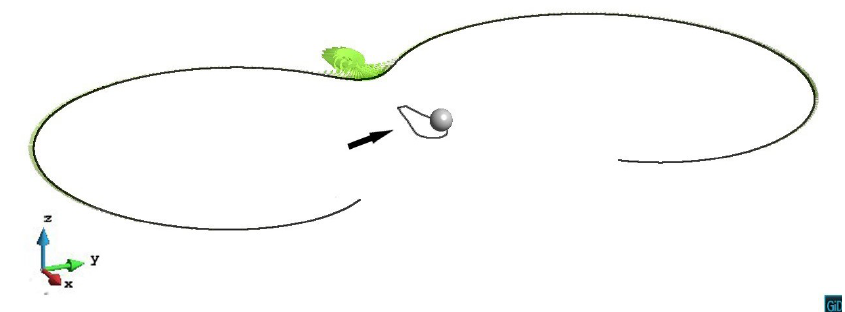
Figure 15. The dislocation nodal velocity vectors and an Orowan loop (black arrow) is left in z / R = − 1.8 case. The plastic strain ε = 6.34 × 10 − 4 .